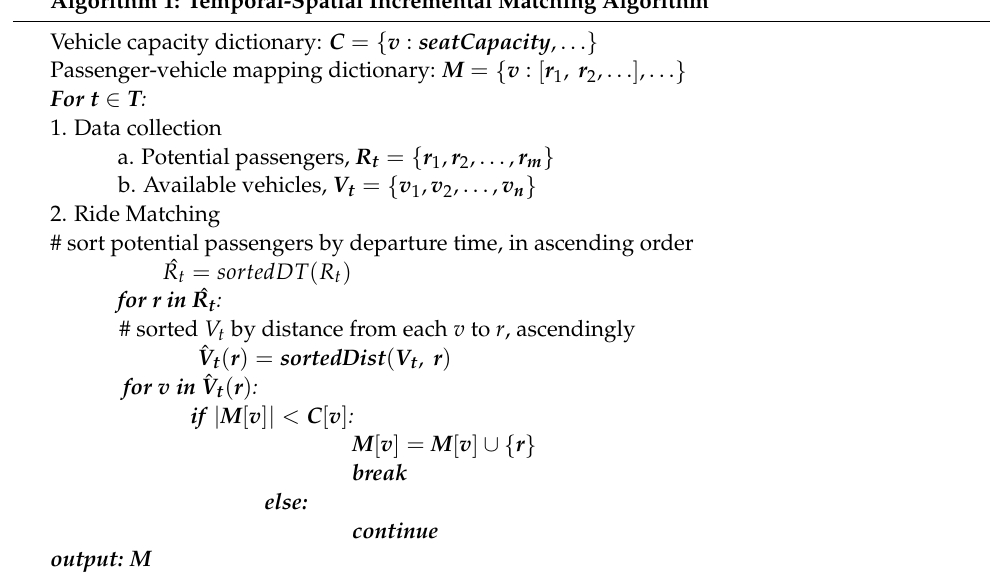
Algorithm 1: Temporal-Spatial Incremental Matching